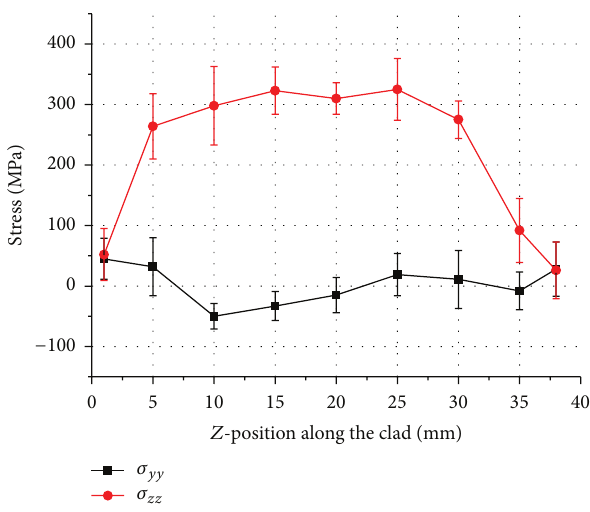
Figure 5: Stress result in sample 1, 0.4DC pulsed laser deposition.